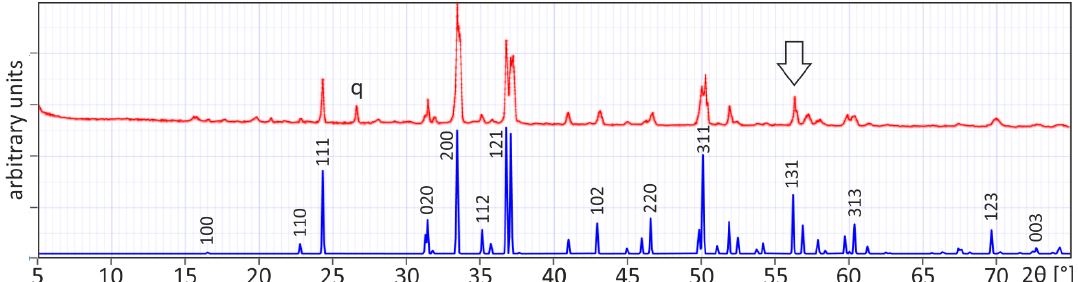
Figure 2. Experimental XRPD pattern of characteristic arsenopyrite sample from Drenjak (sample T1–22), compared with simulated XRPD pattern from [9]. The d 131 peak, used for calculating at.% As in Table 1, is marked with an arrow. The additional diffraction peak at about 2 θ ≈ 27° belongs to quartz (q). Table 1. X-Ray Powder Diffraction (XRPD) results for analysed arsenopyrite samples; α , γ = 90°. Location names are bold italic, and sample names in regular text. The at.% As was calculated from XRPD data according to [14]. Impurities were determined as an average of 15 SEM-EDS analyses.